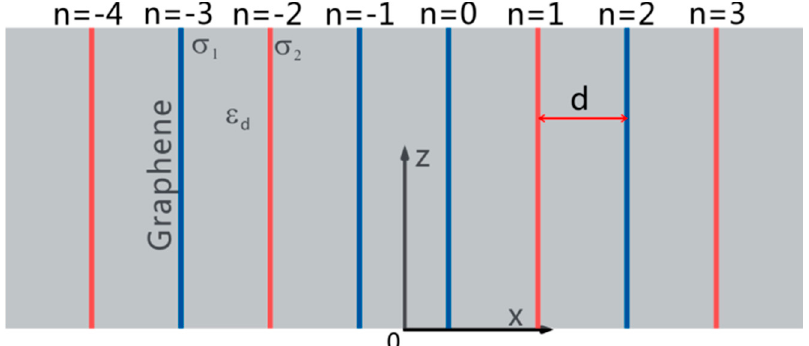
Figure 1. The geometric scheme of graphene waveguide arrays. The red and blue colors represent graphene sheets with different chemical potentials. The center of the structure is a defect. n denotes the waveguide number.